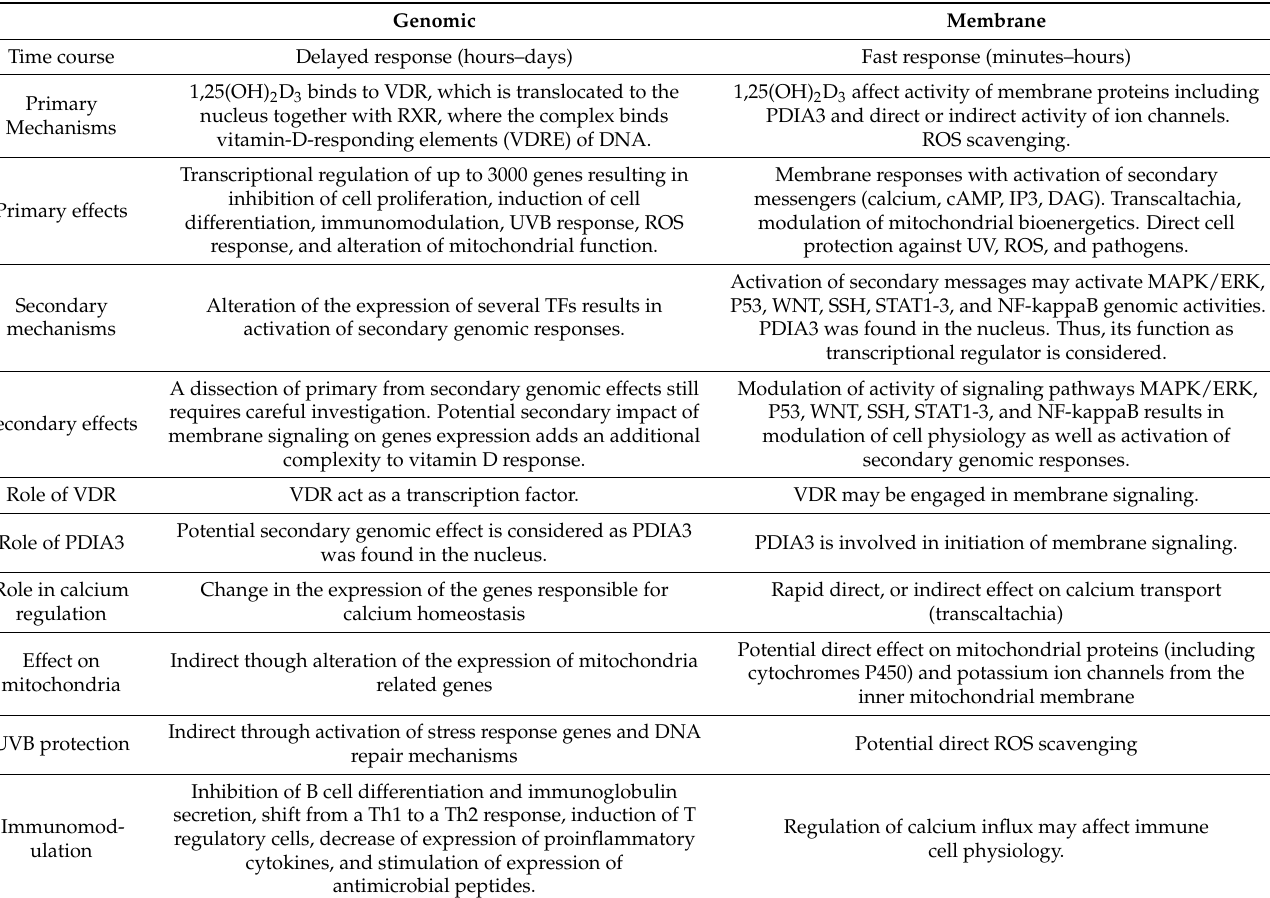
Table 1. Genomic and membrane pathways activated by vitamin